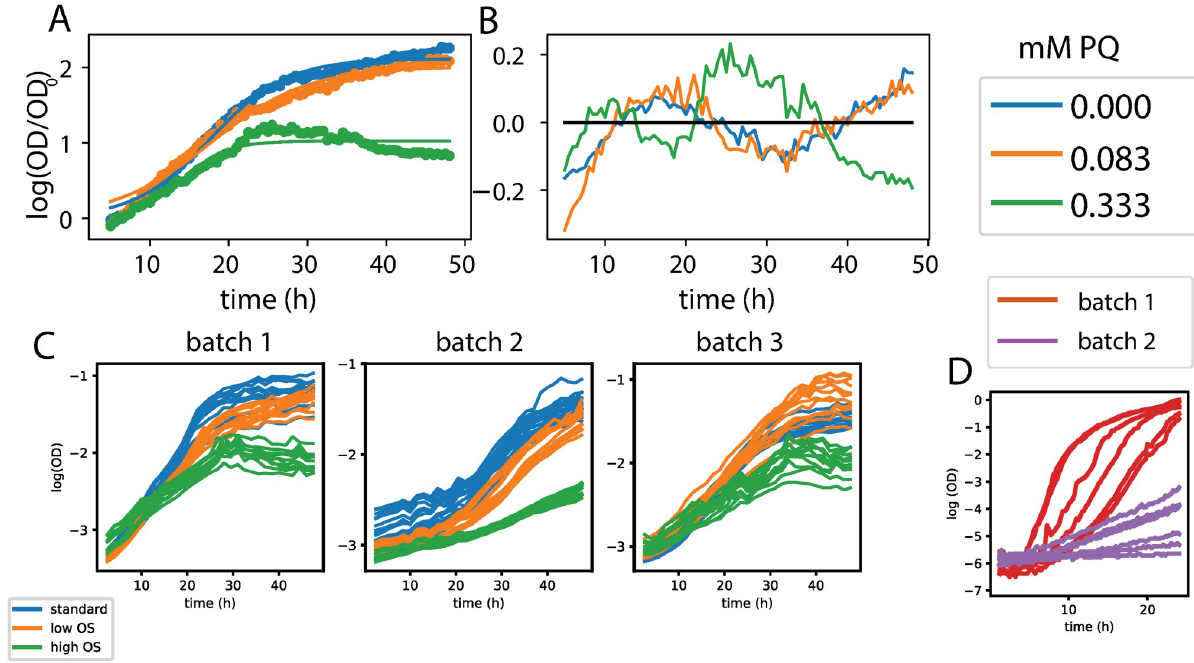
Fig 2. Batch effects are prevalent in microbial phenomic datasets. (A) Parametric fits to H. salinarum growth curves. (B) Residuals of parametric growth curve fit. (C) Growth of H. salinarum under standard conditions (blue), low (orange) and high (green) OS across three batches. (D) Measurement of P. aeruginosa growth under 10mM citric acid at 5.5 pH. Measurements for each condition vary significantly with batch.